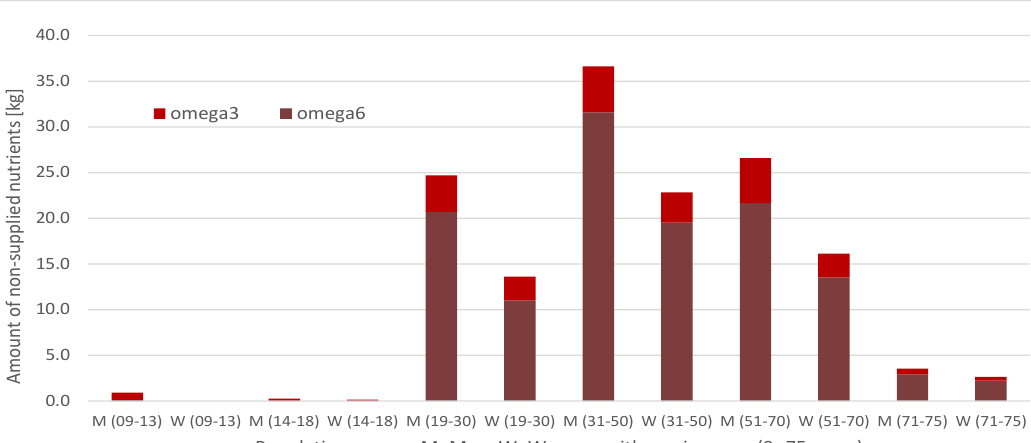
Figure 3. Amounts of distributed food, per food and beneficiary group.